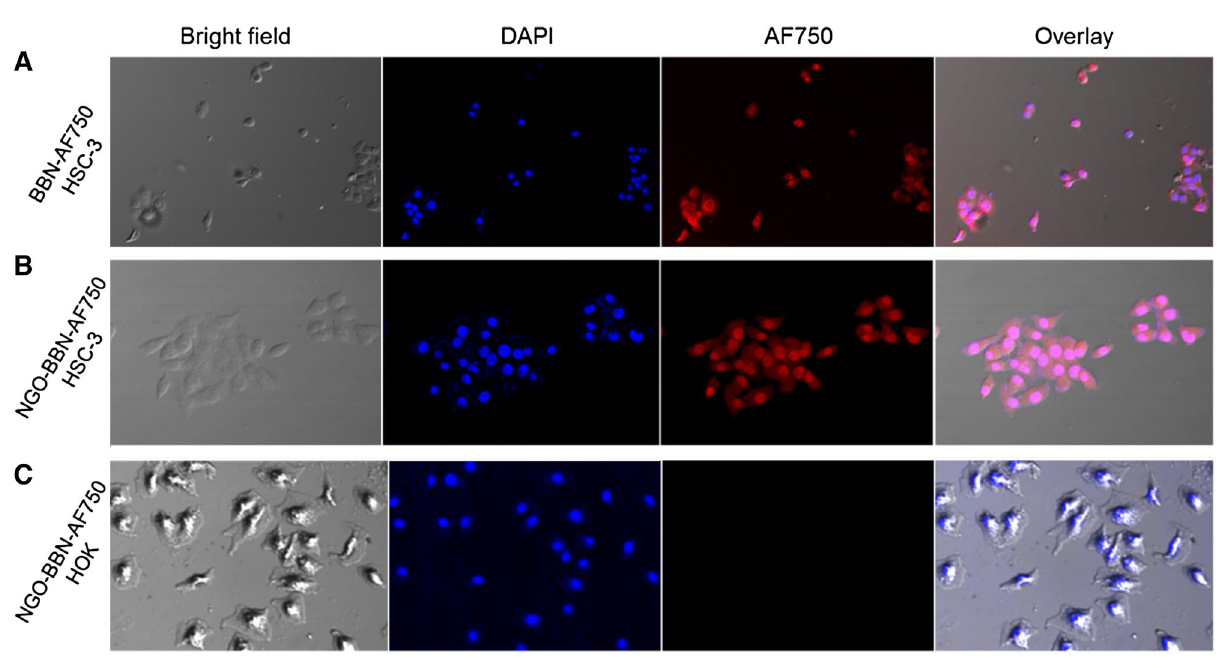
Figure 9. Microscopic images show cell binding of ( A ) AF750-6Ahx-Sta-BBN and ( B ) NGO-BBN-AF750 on HSC-3 cells. ( C ) NGO-BBN-AF750 does not bind to the GRPR-negative HOK cells.